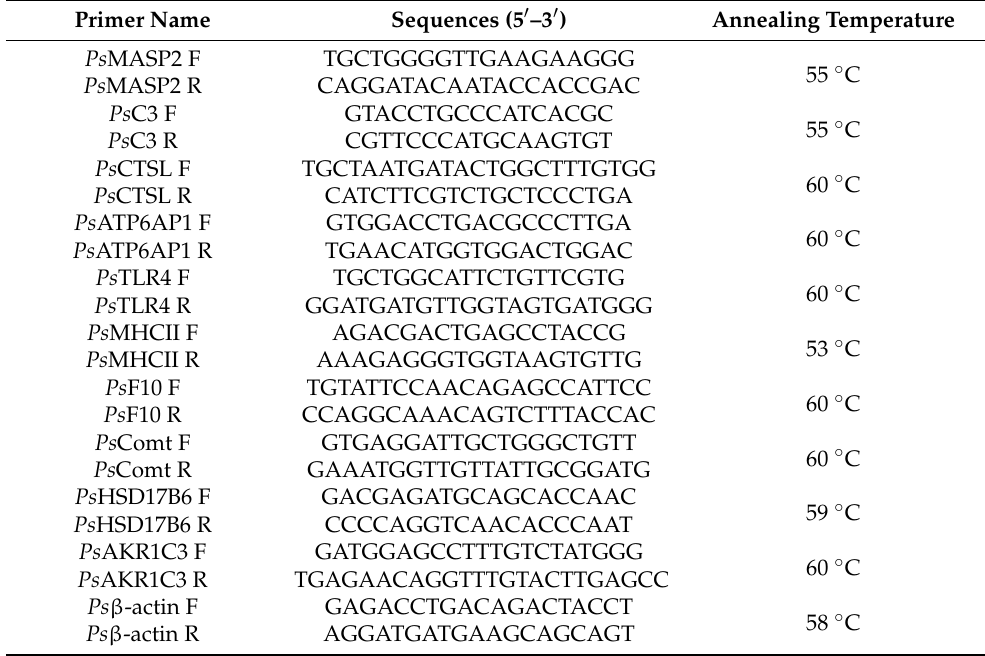
Table 1. Primers used in gene expression validation.